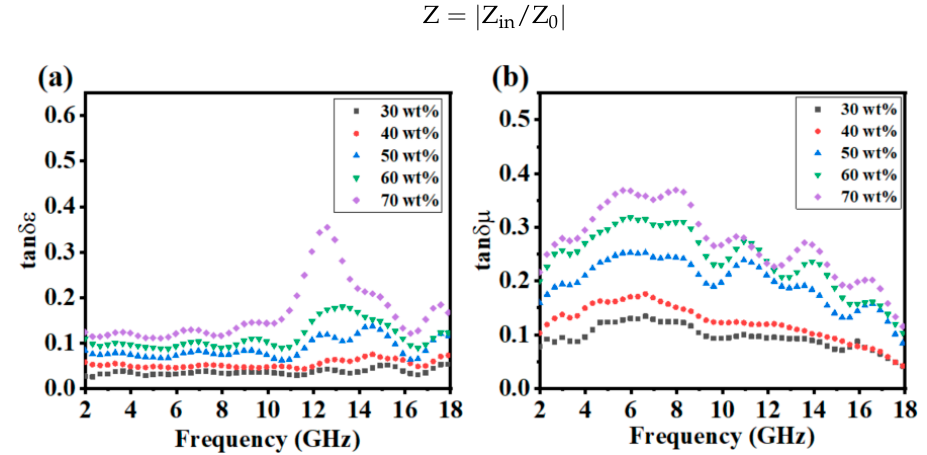
Figure 10. ( a ) The tan δ ε and ( b ) tan δ μ of FeNi 3 alloy with different filling ratios.